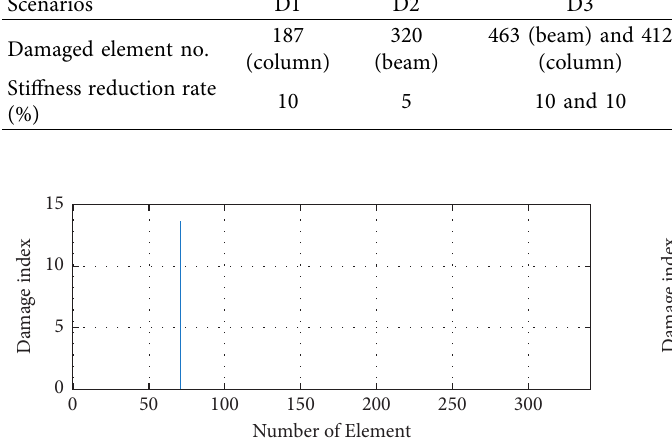
Figure 10: Results of D4 using MCA-DI (L-shape building).